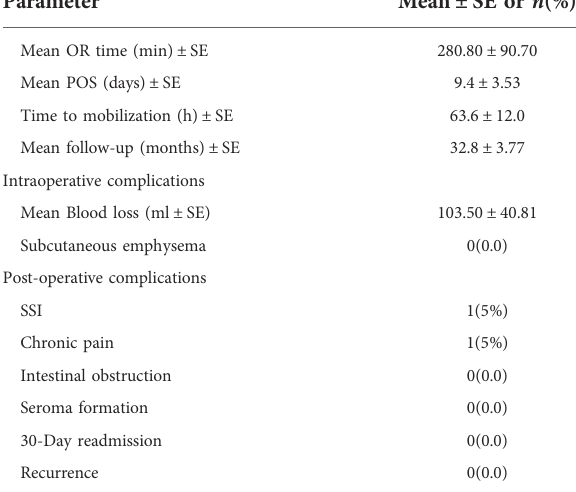
TABLE 4 Perioperative and follow-up time of the patients.